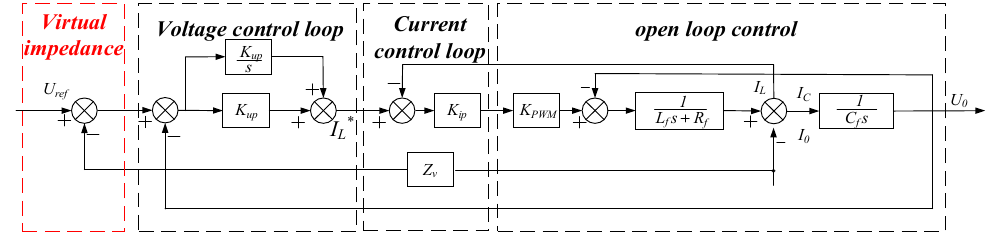
Figure 2. Inverter control block diagram with virtual impedance.